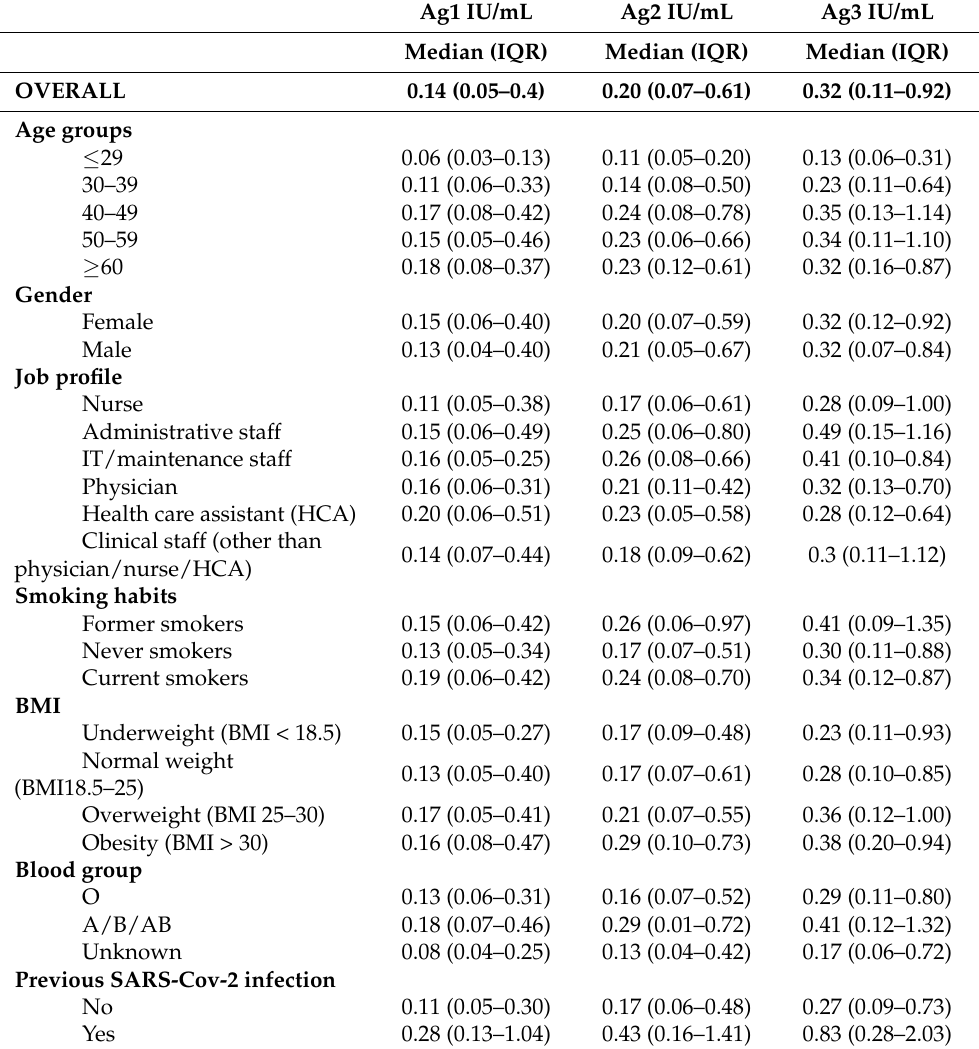
Table 2. Levels of each antigenic stimuli (Ag, median and interquartile range—IQR), by subjects’